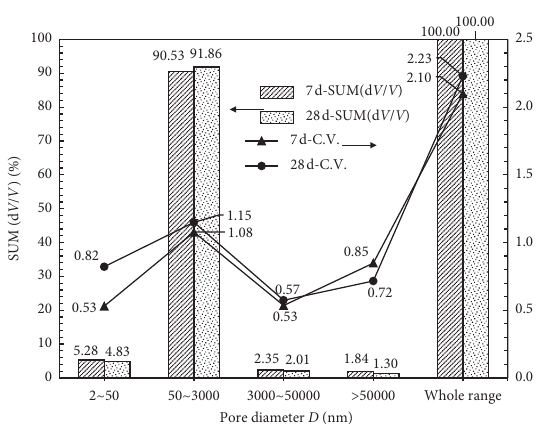
Figure 15: The cumulative pore volume proportion and its C. V. in pore-diameter ranges of different W/C ratio NCG concretion.